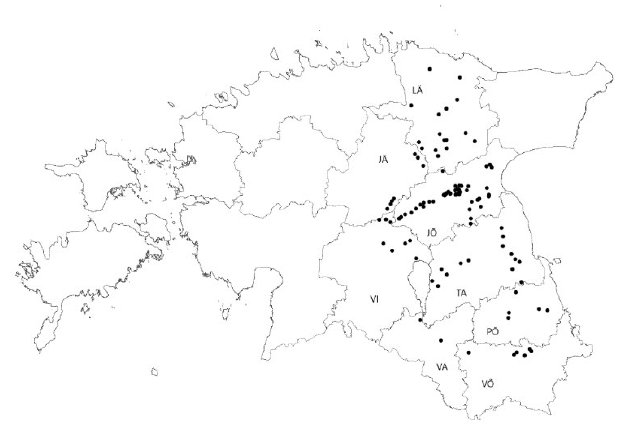
Fig. 1. Pollen beetle sampling sites in 2015–2019. Estonian counties: LÄ = Lääne-Viru; JÕ = Jõgeva; TA = Tartu; PÕ = Põlva; VÕ = Võru; VA = Valga; VI = Viljandi; JÄ =